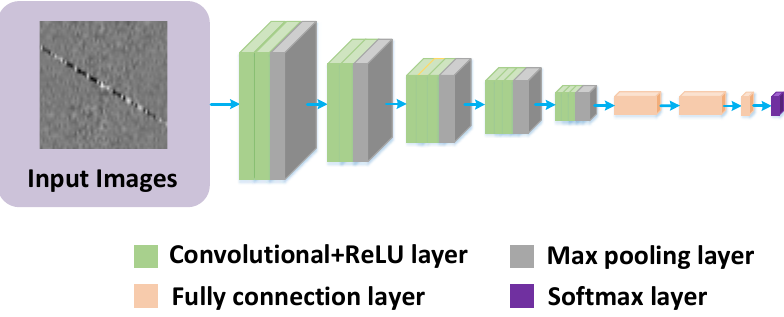
Figure 3. The interference detection network (IDN) framework.